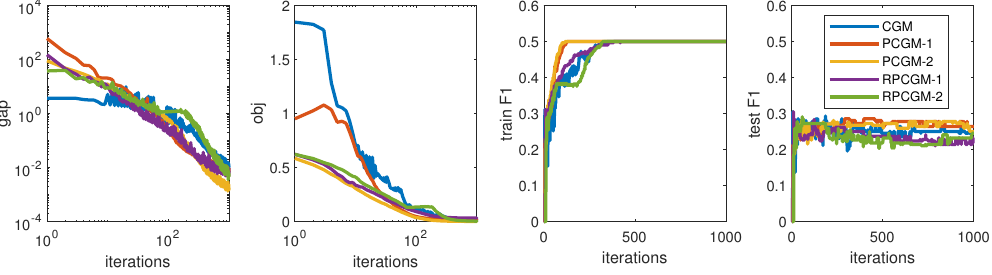
Figure 6 Dorothea classification experiment For CGM, α = 100. PCGM-1 and RPCGM-1 uses p = 2, and PCGM-2 and RPCGM-2 uses p = 5. Additionally, RPCGM-1 and RPCGM-2 both use θ = c = 1 /